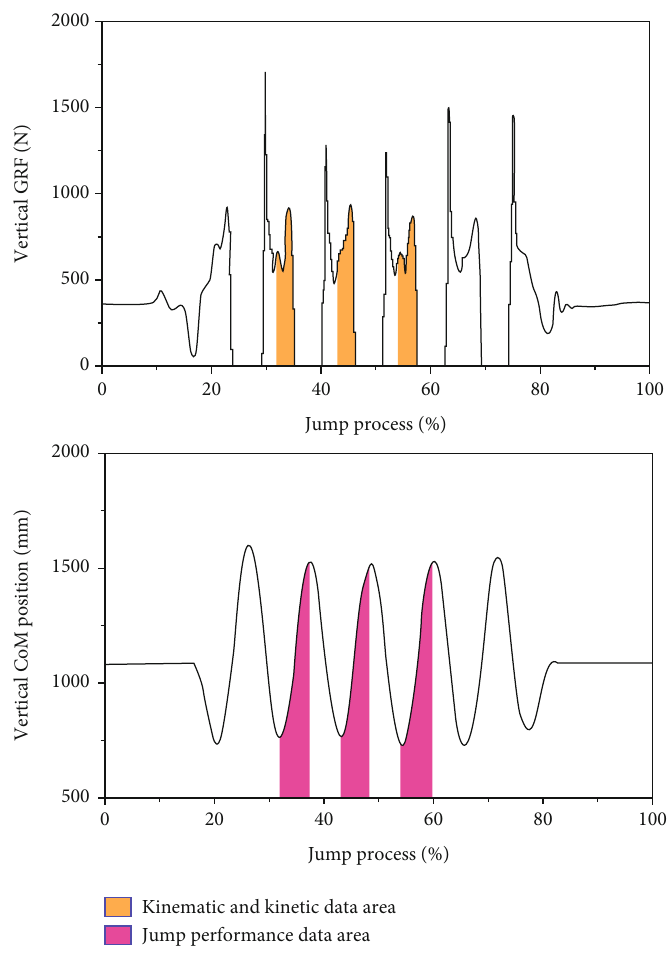
Figure 4: Data analysis area in consecutive jump.